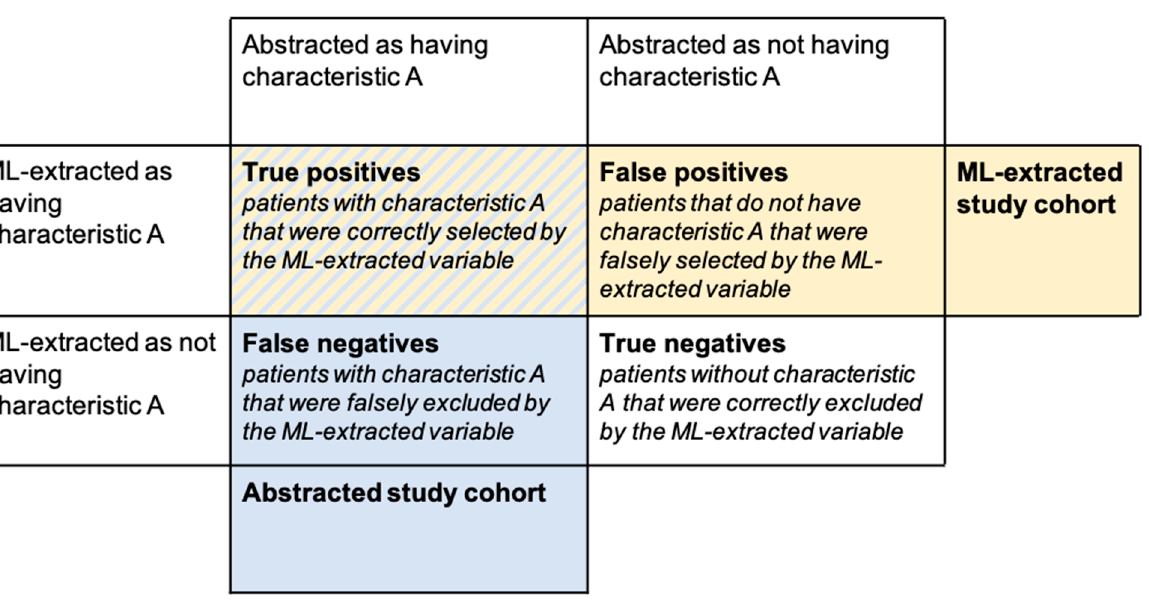
Figure 2. Confusion matrix for model errors.